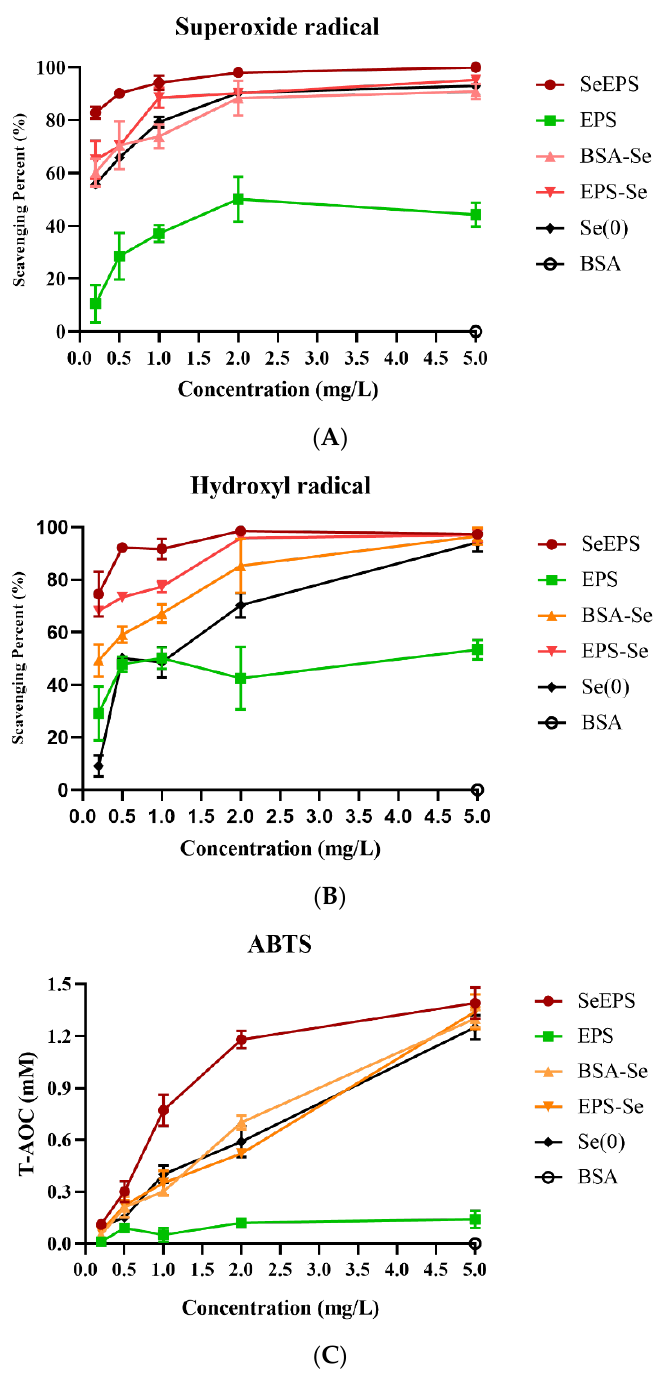
Figure 4. Free radical scavenging activities of SeEPS, EPS, EPS-Se, BSA-Se and Se(0): ( A ) scavenging activity of superoxide radical, ( B ) scavenging activity of hydroxyl radical and ( C ) scavenging activity of ABTS radical. BSA is used as a negative